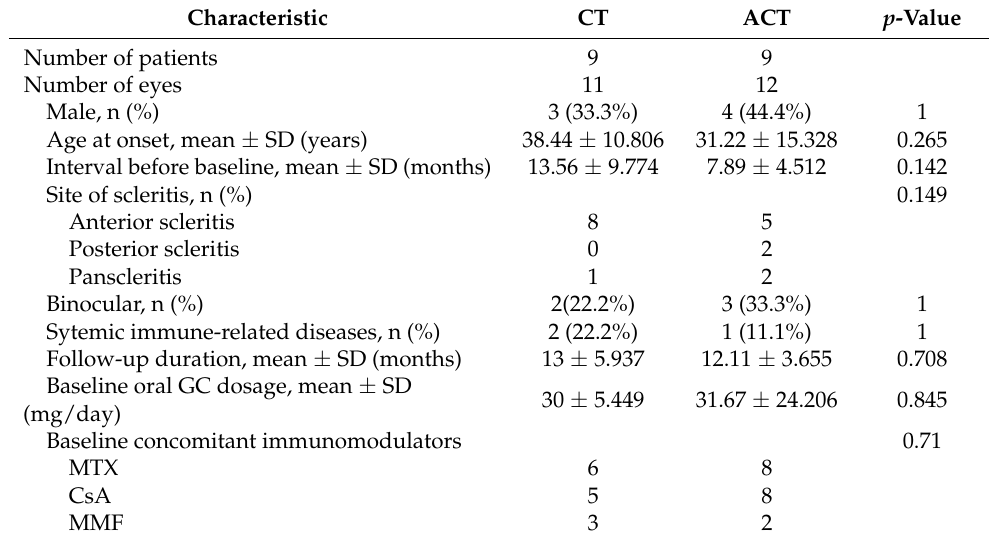
Table 1. Patients’ demographics and clinical characteristics.